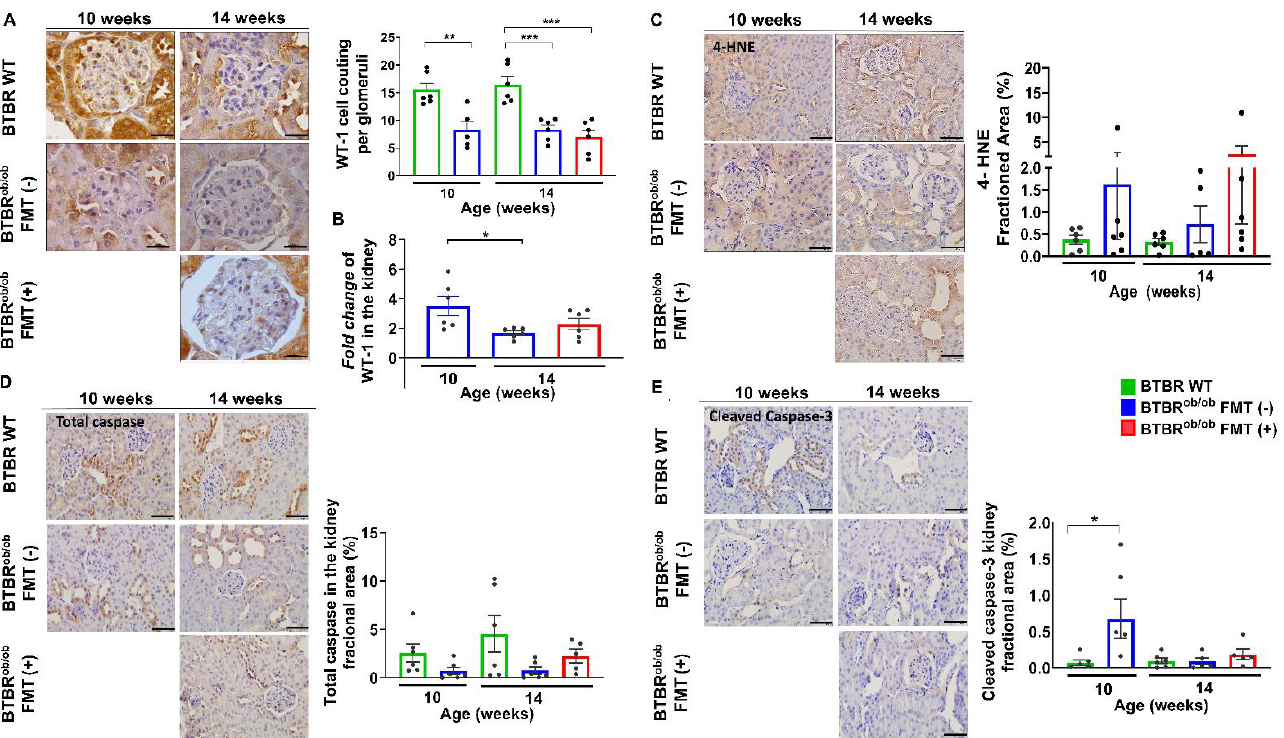
Figure 5. Immunohistochemical analysis of WT-1, total caspase, cleaved caspase-3, and 4-hydroxy- 2-noneal (4-HNE) in the kidneys of BTBR ob/ob FMT ( − ) and FMT (+) mice compared to BTBR WT mice. ( A ) BTBR ob/ob mice exhibited lower detection of WT-1 + cells in all ages when compared